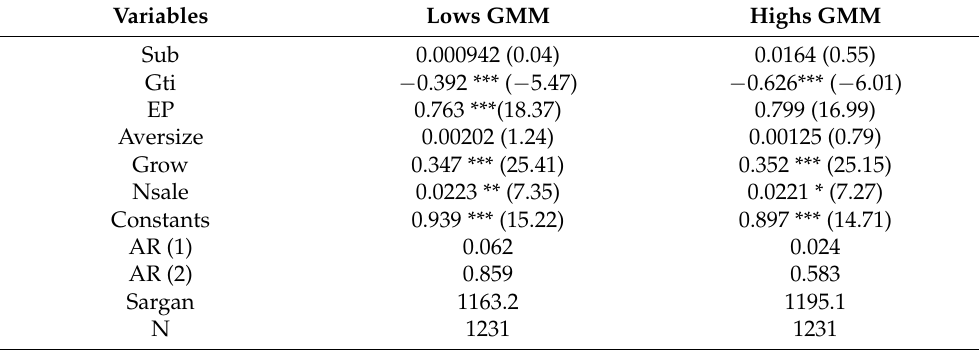
Table 8. Robustness